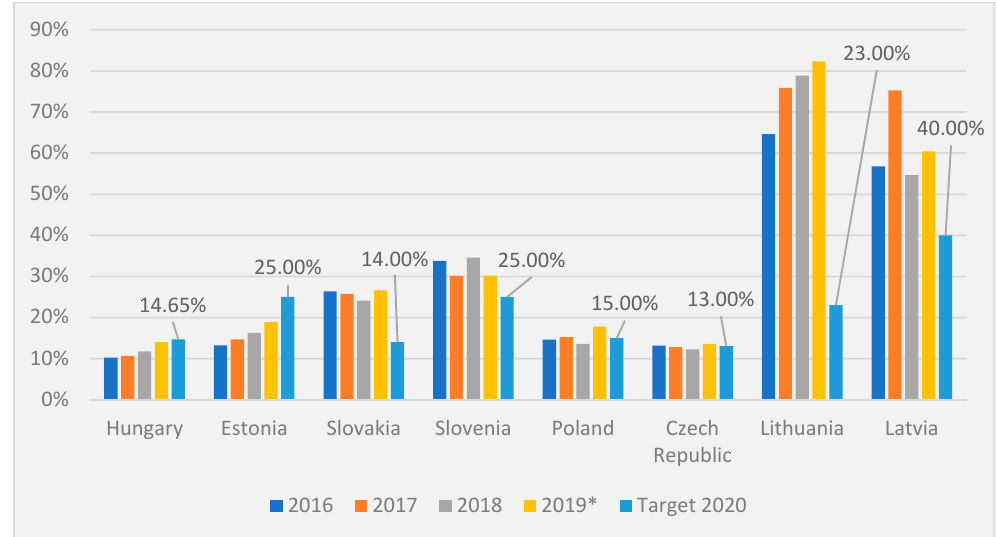
Figure 2. Electricity generation from renewable sources; share in the overall energy production for selected countries, 1990–2018 (in %). Data source: [3,4]. * The data for 2019 covers only the period from January to May.